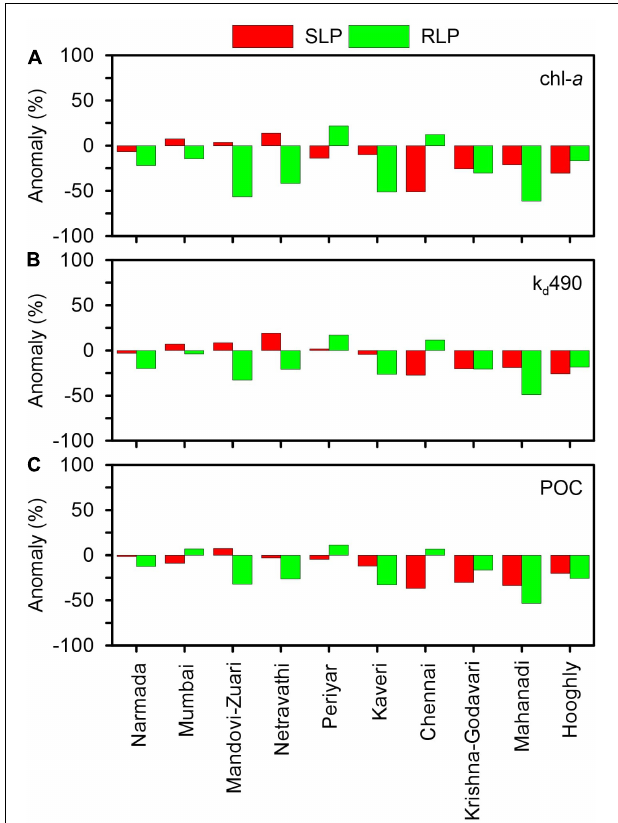
FIGURE 7 | Mean anomaly of (A) chl- a , (B) k d 490, and (C) POC during strict (March 25 to April 14, 2020) and relaxed lockdown (April 15 to May 31, 2020) off major Indian cities and river